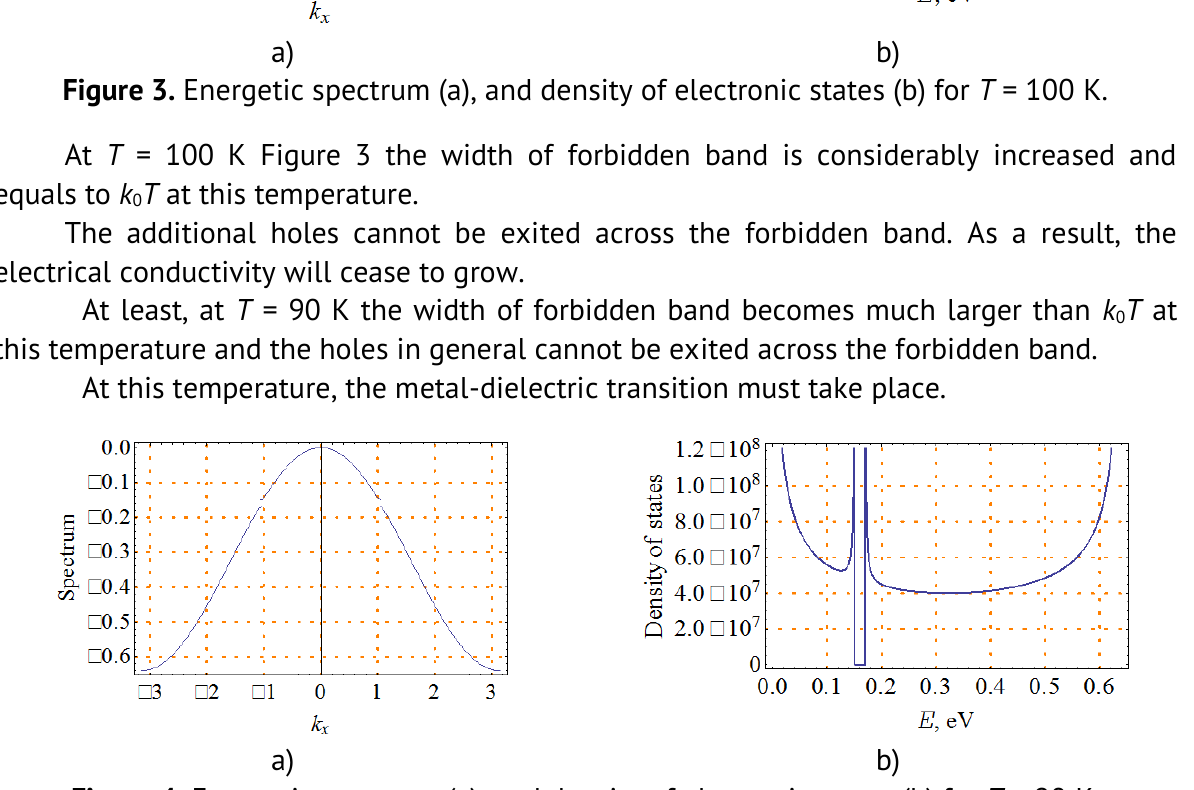
Figure 4. Energetic spectrum (a), and density of electronic states (b) for T = 90